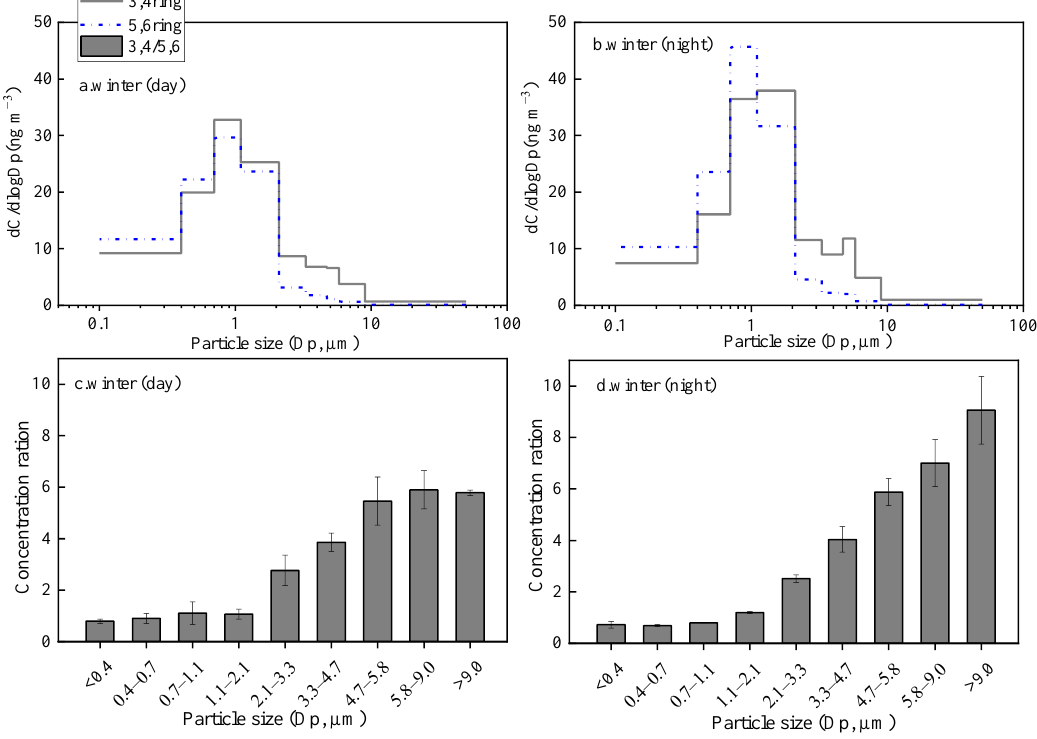
Figure 7. Particle size distributions (( a ). winter day; ( b ). winter night) and Particle size concentration distributions (( c ). winter day; ( d ). winter night) of PAHs in winter. (error bars represent min.–max. concentrations).